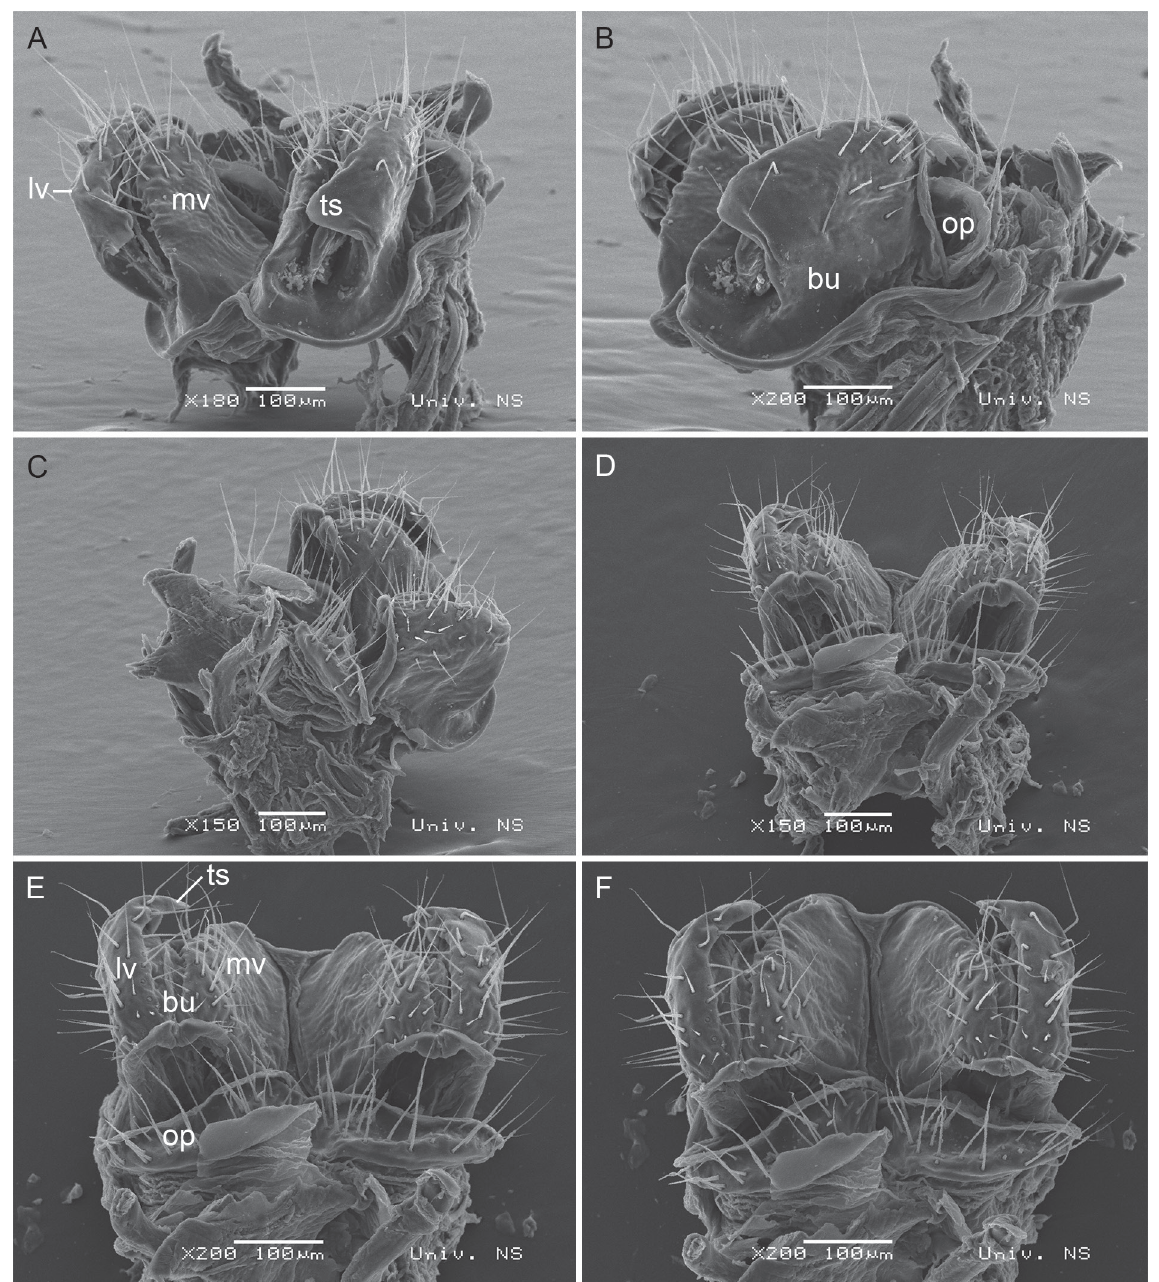
Fig. 3. Biokoviella mauriesi Mršić, 1992, ♀ from the Lovricia 3 Pit, vulvae. A . Posterior view. B . Lateral view. C . Latero-distal view. D . Anterior view. E . Antero-distal view. F . Distal view. Abbreviations: see Material and